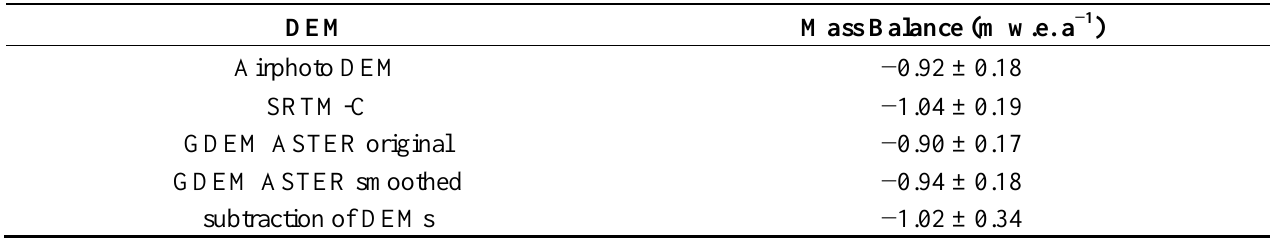
Table 4. Mass balance of the Grosser Aletschgletscher estimated from ICESat measurements for the period 2003–2009 using different DEMs as elevation reference and from the subtraction of the DEMs for the years 1999 and